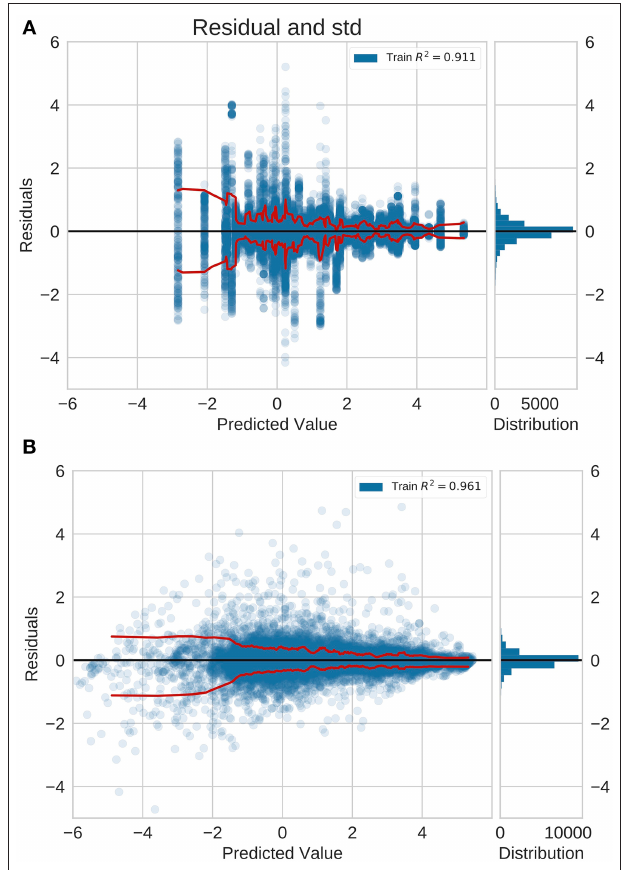
FIGURE 2 | Residual plots for (A) naive baseline and (B) NN predictions with feature fusion for previously unseen countries on the GBD dataset. Red lines indicate the standard deviation. This is also the logarithm of the error. It is positive (negative) if the ML model overestimates (underestimates) the true value. The plots show that the errors for diseases with a higher incidence rate are